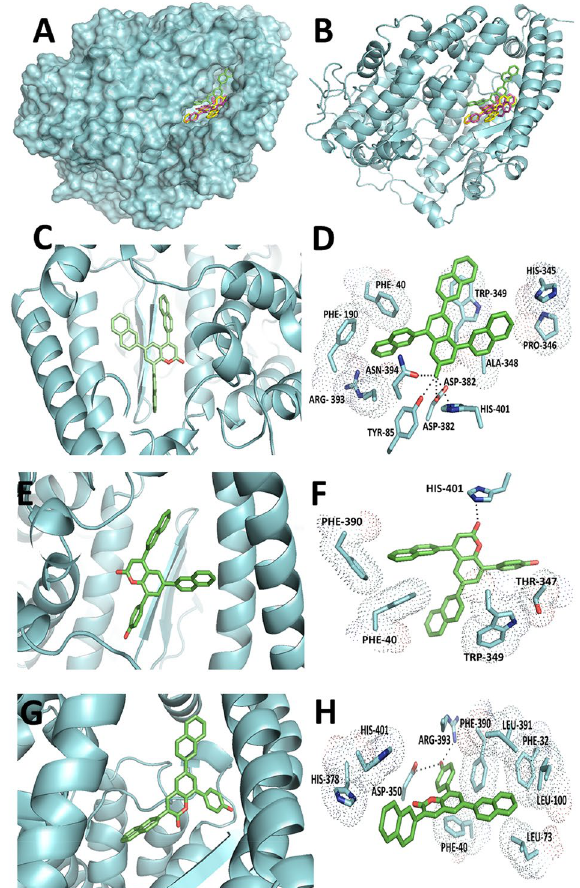
Figure 1. Binding site of NF-1, NF-12, and NF-13 on S-protein-ACE2 complex. ( A ) The binding site of NF-1, NF-12, and NF-13 on the S-protein-ACE2 receptor complex. ( B ) The putative binding site of NF-1, NF-12, and NF-13 on the S-protein-ACE2 receptor complex. ( C ) The zoomed view of the binding site of NF-1 on the S-protein-ACE2 receptor complex. ( D ) The interacting amino acid residues of ACE2 with NF-1. ( E ) The zoomed view of the binding site of NF-12 on the S-protein-ACE2 receptor complex. ( F ) The interacting amino acid residues of ACE2 with NF-12. ( G ) The zoomed view of the binding site of NF-13 on the S-protein- ACE2receptor complex. (H) The interacting amino acid residues of ACE2 with